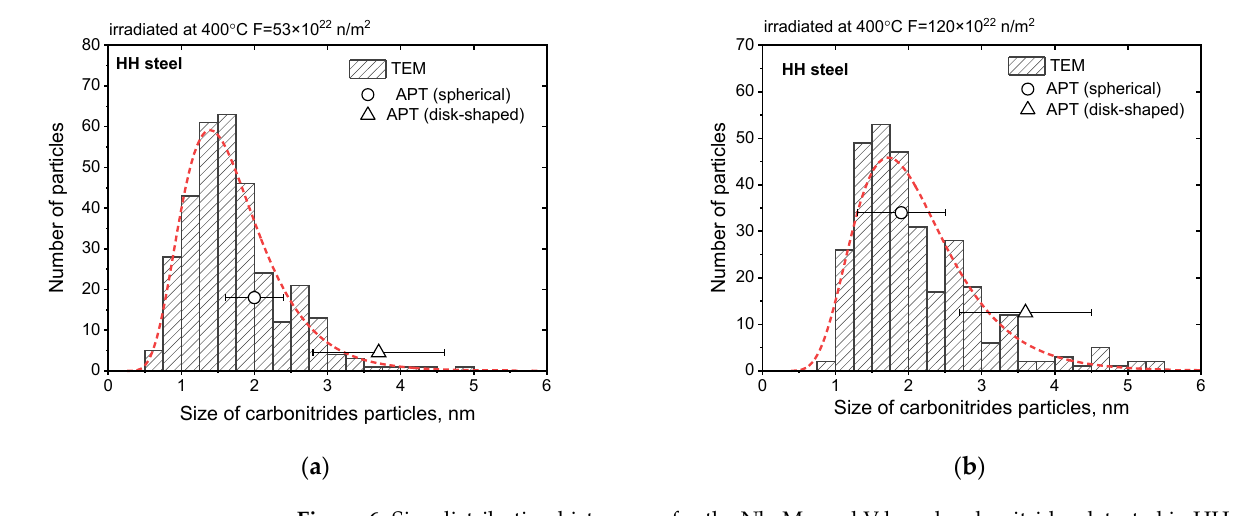
Figure 6. Size distribution histograms for the Nb, Mo and V-based carbonitrides detected in HH steel after irradiation at 400 °C up to fast neutron fluences 53 × 10 22 n/m 2 ( a ) and 120 × 10 22 n/m 2 ( b ).